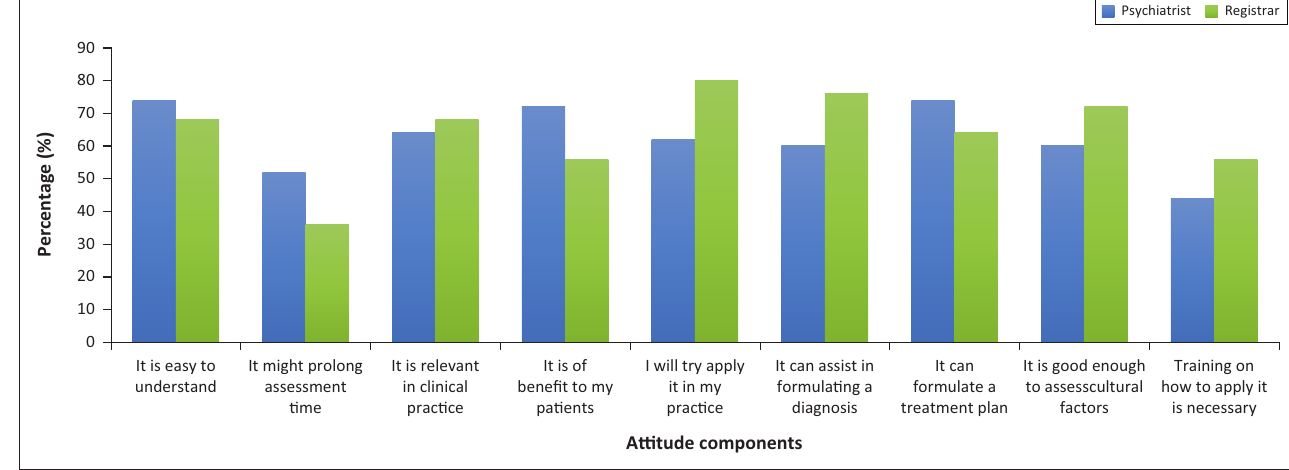
FIG URE 3: Attitude responses according to years of experience.